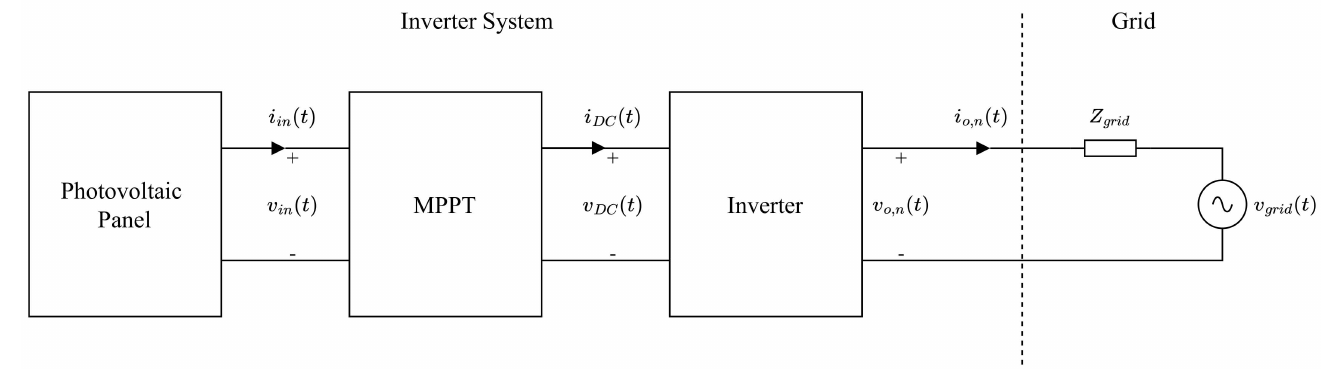
Figure 12. Block diagram of the inverter system under normal operating conditions.